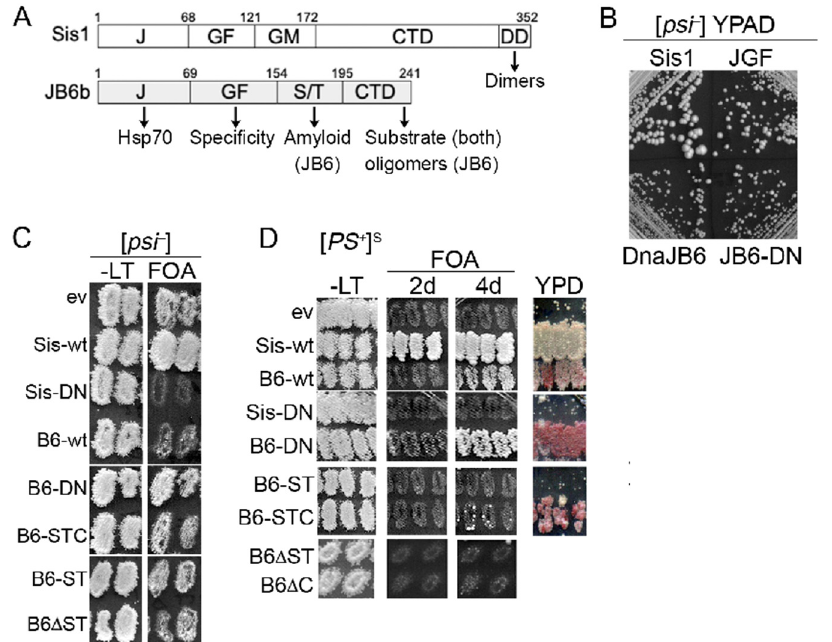
Figure 1. DnaJB6 protects yeast from toxicity of [ PSI + ] S . ( A ) Structures of Sis1 and DnaJB6b (JB6b) drawn near to scale. Numbers indicate amino acid residues that delineate structural domains. J-domain mediates interaction with Hsp70, GF (DnaJB6) and GF/GM (Sis1) confer functional specificity, ST of DnaJB6 interacts with amyloid, and CTD binds misfolded protein substrates. Terminal CTD region of Sis1 encodes a dimerization region (DD); CTD of DnaJB6 is important for forming higher- order oligomers [25]. ( B ) FOA-resistant [ psi − ] cells expressing Sis1JGF only or Sis1JGF plus indicated proteins were grown on rich medium for 3 days at 30 ◦ and 1 day at 22 ◦ . ( C ) Plasmid shuffle (see text) using strain 970L S . All are sis1 ∆ and express Sis1 from a URA3 plasmid, Sis1JGF from a LEU2 plasmid and test protein indicated on left from a TRP1 plasmid. Cells grown on SC -Leu-Trp (-LT) were replica-plated onto similar medium containing FOA and grown 2 days. ( D ) Same as ( C ) but [ PSI + ] S cells. FOA plate was incubated 2–4 days as indicated at top. FOA plate was replica-plated onto 1/2YPD (YPD), which has limiting amount of adenine to monitor prion color phenotype. For ( C , D ); ev, empty TRP1 vector (Sis1JGF alone); B6, DnaJB6b. To test if intact or mutant versions of DnaJB6b could counteract toxicity of [ PSI + ] S when expressed in place of Sis1 we used a “plasmid shuffle” assay to exchange TRP1 plasmids encoding test proteins for a URA3 plasmid encoding Sis1 (pYW17) [19]. Our sis1